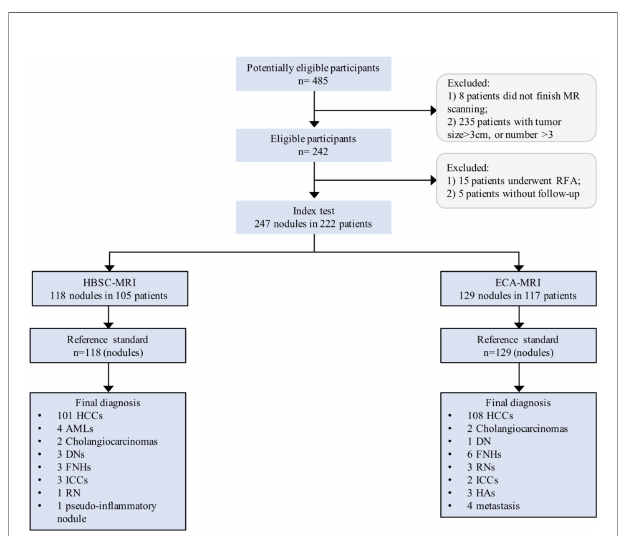
FIGURE 1 | Flowchart of the study population. HCC, hepatocellular carcinoma; AML, angiomyolipoma; DN, dysplastic nodule; FNH, focal nodular hyperplasia; ICC, intrahepatic cholangiocarcinoma; RN, regenerative